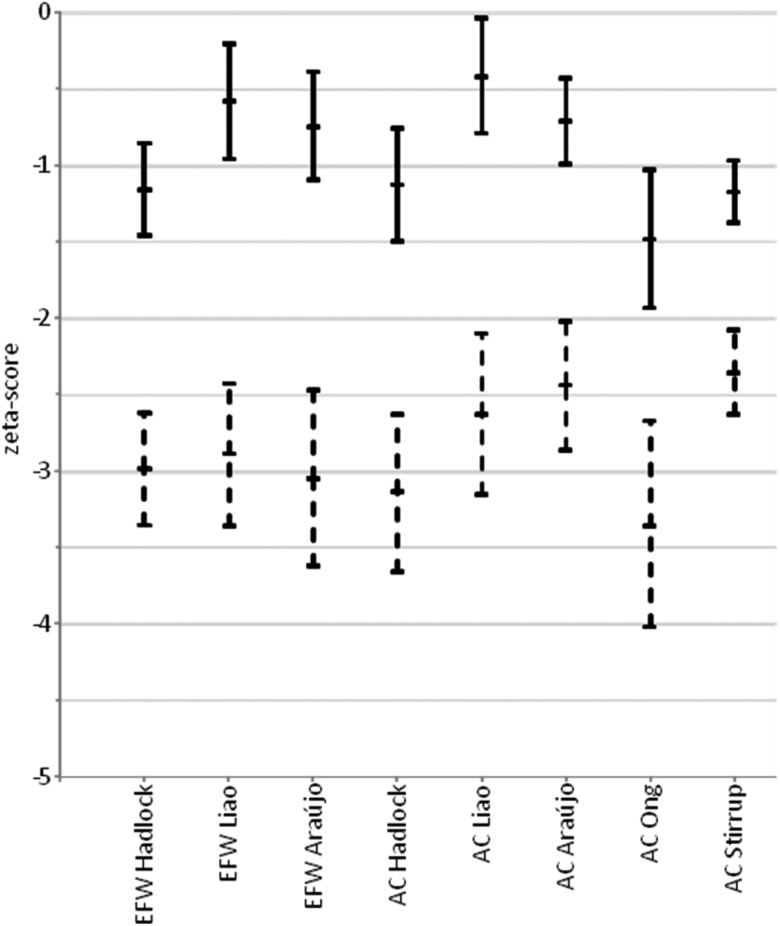
Mean estimate and 95% confidence interval for estimated fetal weight (EFW) and abdominal circumference (AC) zeta-score values according to different reference ranges in 47 twin pregnancies with placental insufficiency. Dashed lines: absent or reverse end-diastolic flow in the umbilical artery group; continuous lines: normal umbilical artery Doppler group.